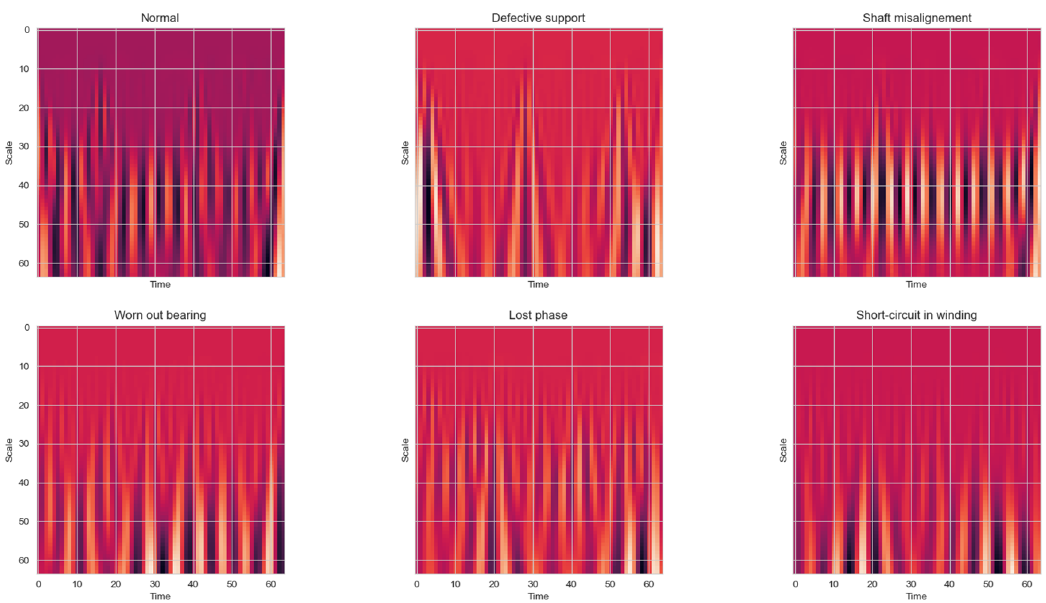
Figure 7. One sample of resulting scalograms shaped at 64 × 64 with all six classes.